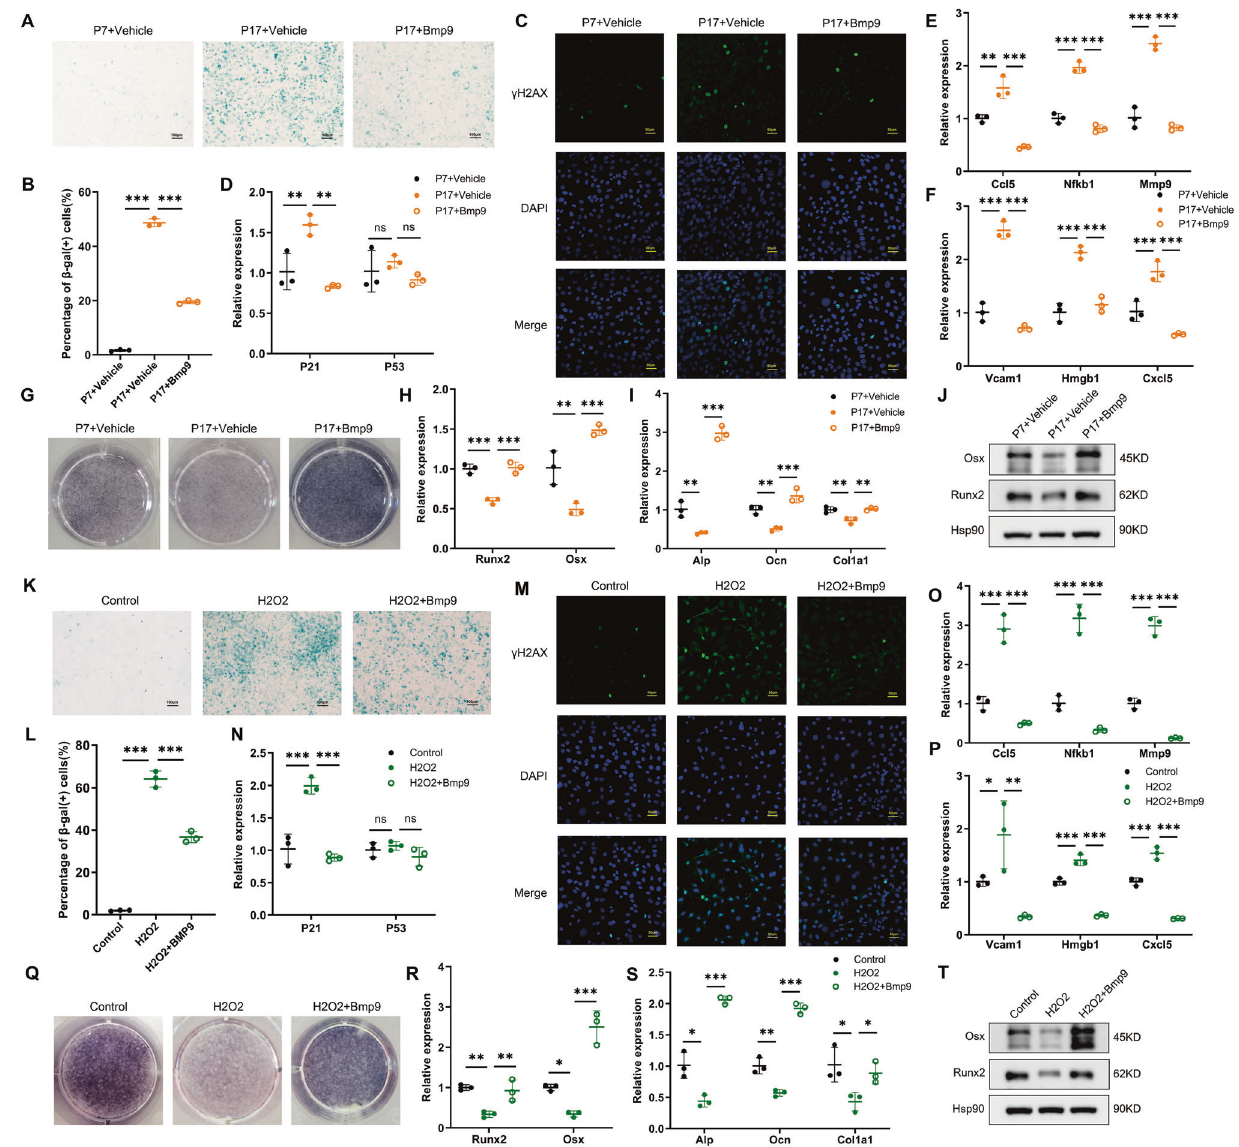
Fig. 4 BMP9 attenuates senescence and promotes osteoblast differentiation in MC3T3-E1 cells. Passage 7 of MC3T3-E1 cells were treated with vehicle as control group. Passage 17 of MC3T3-E1 cells were treated with vehicle or BMP9 for 3 days, respectively. A , B β -galactosidase staining was performed ( A ) and number of β -gal ( + ) cells was counted for each group ( B ) (Scale bar, 100 μ m). C Immuno fl uorescence analysis of γ -H2AX expression (Scale bar, 50 μ m). D qPCR analysis of mRNA levels of senescent genes P21 and P53. E , F qPCR analysis of mRNA levels of SASPs. G Alp staining of MC3T3-E1 cells suffered to osteogenic differentiation induction for 7 days with or without BMP9. H , I qPCR analysis of osteoblast differentiation markers in cells suffered to osteogenic differentiation induction for 7 days with or without BMP9. J Western blot analysis of protein levels of Runx2 and Osx in MC3T3-E1 cells suffered to osteogenic differentiation induction for 7 days with or without BMP9. Senescence of MC3T3-E1 cells was also induced by H 2 O 2 treatment for 2 h, then fresh culture medium added with vehicle or BMP9 was replaced for another 3 days. K , L β -galactosidase staining was performed ( K ) and number of β -gal ( + ) cells was counted for each group ( L ). (Scale bar, 100 μ m). M Immuno fl uorescence analysis of γ -H2AX expression (Scale bar, 50 μ m). N qPCR analysis of mRNA levels of senescent genes P21 and P53. O , P qPCR analysis of mRNA levels of SASPs. Q ALP staining of control and H 2 O 2 -stimulating MC3T3-E1 cells suffered to osteogenic differentiation induction for 7 days with or without BMP9. R , S qPCR analysis of osteoblast differentiation markers in control and H 2 O 2 -stimulating MC3T3-E1 cells suffered to osteogenic differentiation induction for 7 days with or without BMP9. T Western blot analysis of protein levels of Runx2 and Osx in control and H 2 O 2 -stimulating MC3T3-E1 cells suffered to osteogenic differentiation induction for 7 days with or without BMP9. Data presented as mean ± SD. n = 3 biological replicates. One-way ANOVA was used for comparison among multiple groups. * P < 0.05; ** P < 0.01; *** P < 0.001. Ns, no signi fi cance. H 2 O 2 -induced senescent cells (Fig. 8D – F). The number of P21 ( + ) activity of Stat1 was obviously downregulated, indicating the inhibitory effect of Smad1 on Stat1 promoter activity (Fig. 8C). Stat1 ( + ) cells was also increased with LDN193189 (Fig. 8G). With the use of Smad1/5/9 signaling pathway inhibitor Moreover, reduction of Ccl5, Nfkb1, Mmp9, Vcam1 and Cxcl5 in LDN193189 [33], activation of Smad1 induced by BMP9 was BMP9-treated senescent osteoblasts was partially neutralized by inhibited, resulting in increased expression of Stat1 and P21 in the application of LDN193189 (Fig. 8H, I). Cell Death Discovery (2022)